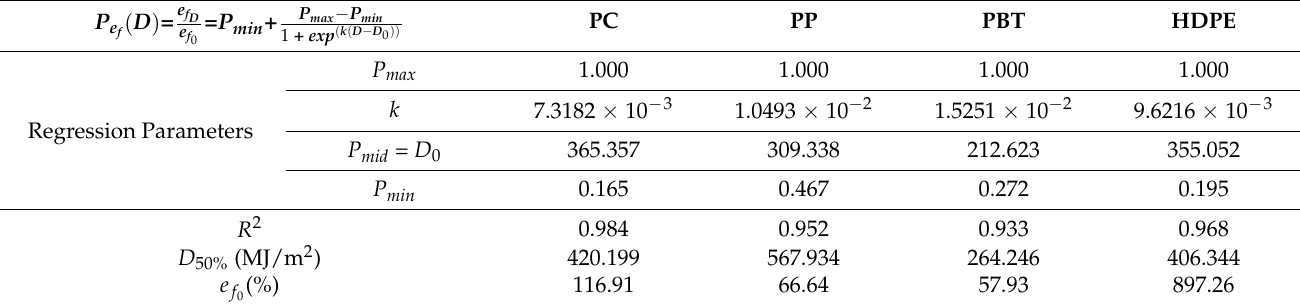
Table 5. Regression parameters of each polymer for inverted S-shaped model for fracture strain